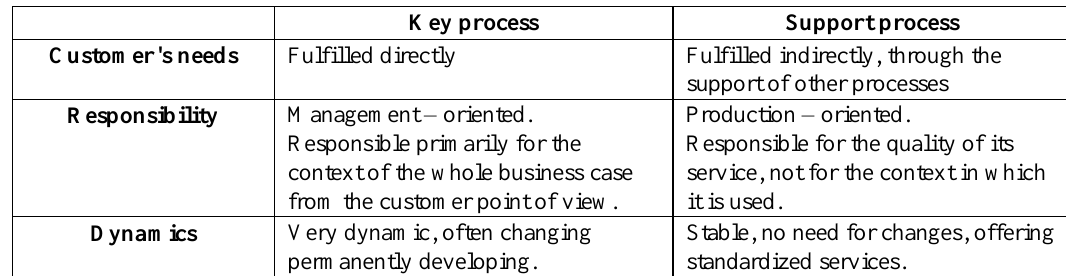
Table 1. Key versus Support